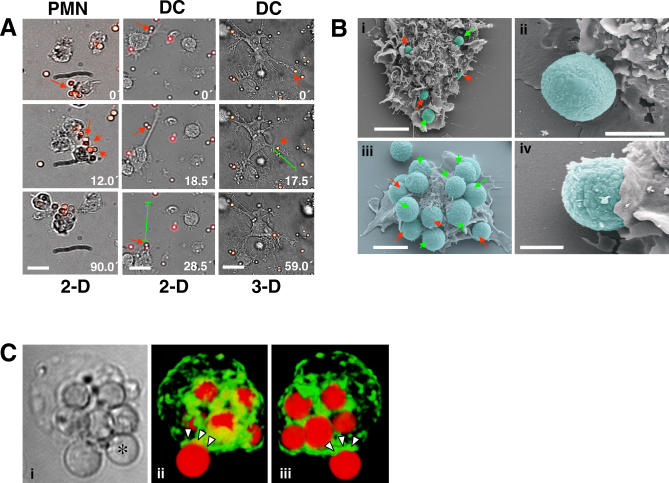
Dragging Is a Major Interaction Type of DC or PMN with Conidia of A. fumigatus
(A) Time series from videos of A. fumigatus conidia and PMNs and DCs in 2-D and in 3-D systems show dragging as an alternative way of interaction between phagocytes and A. fumigatus conidia. The conidia are dragged by the PMNs in the form of a cluster. DCs are able to drag conidia over several micrometers (shown in green). Bar = 25 μm.(B) Electron microscope images of DCs (i) and (ii) and PMN (iii) and (iv) are shown interacting with conidia, which were pseudocolored blue to enhance contrast. Dragging and ongoing phagocytosis as seen in time-lapse imaging is evident in the form of several conidia attached to a single DC or PMN (shown here in green arrows), as well as in the process of being incorporated into (indicated by red arrows) a single DC or PMN in the high resolution electron microscopy image (Bar = 5 μm). (ii) shows an attached conidium to a DC, and (iv) shows a conidium being phagocytosed by a PMN (Bar = 2μm).(C) Attached and internalized conidia associated with the same PMN. PMNs were fixed and permeabilized during interaction with DsRed conidia. Subsequently, cells were stained with Alexa 488 labeled phalloidin. Two-color confocal microscopy was used to obtain a z stack covering the entire cell thickness. Shown is the transmission light image (i) as well as two views of a voxel rendering of composite red (fungus) green (actin) fluorescence images. (ii) corresponds to the same view as (i) and (iii) corresponds to a 180-degree rotation in the plane of the paper showing that five conidia are entirely covered by actin cytoskeleton pockets, while the sixth conidium is in the process of being phagocytosed as depicted by actin protrusions (arrowheads). These protrusions correspond to those depicted in (B) (iv). The conidium marked with an asterisk is not visible in the fluorescence image due to the loss of fluorescence. Also refer to Video S9.